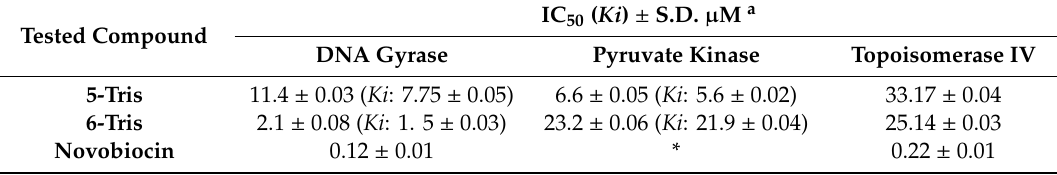
Table 2. MRSA DNA gyrase-B, pyruvate kinase, and topoisomerase IV inhibitions as IC 50 and inhibition constant Ki